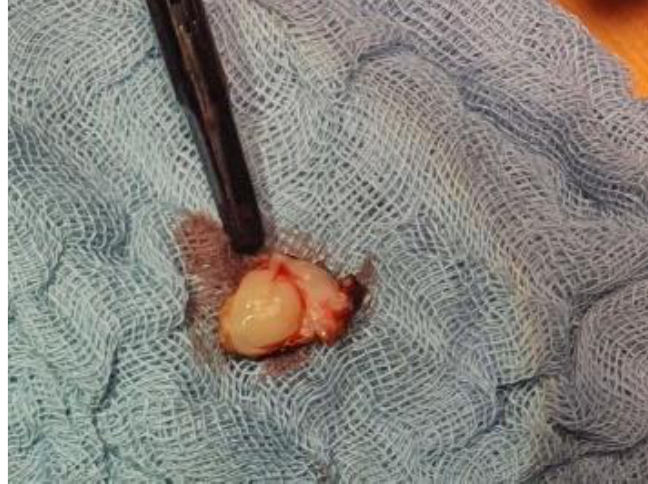
Figure 3. Left ventricle tumour implanted at the base of the anterolateral papillary muscle (blue arrow) .